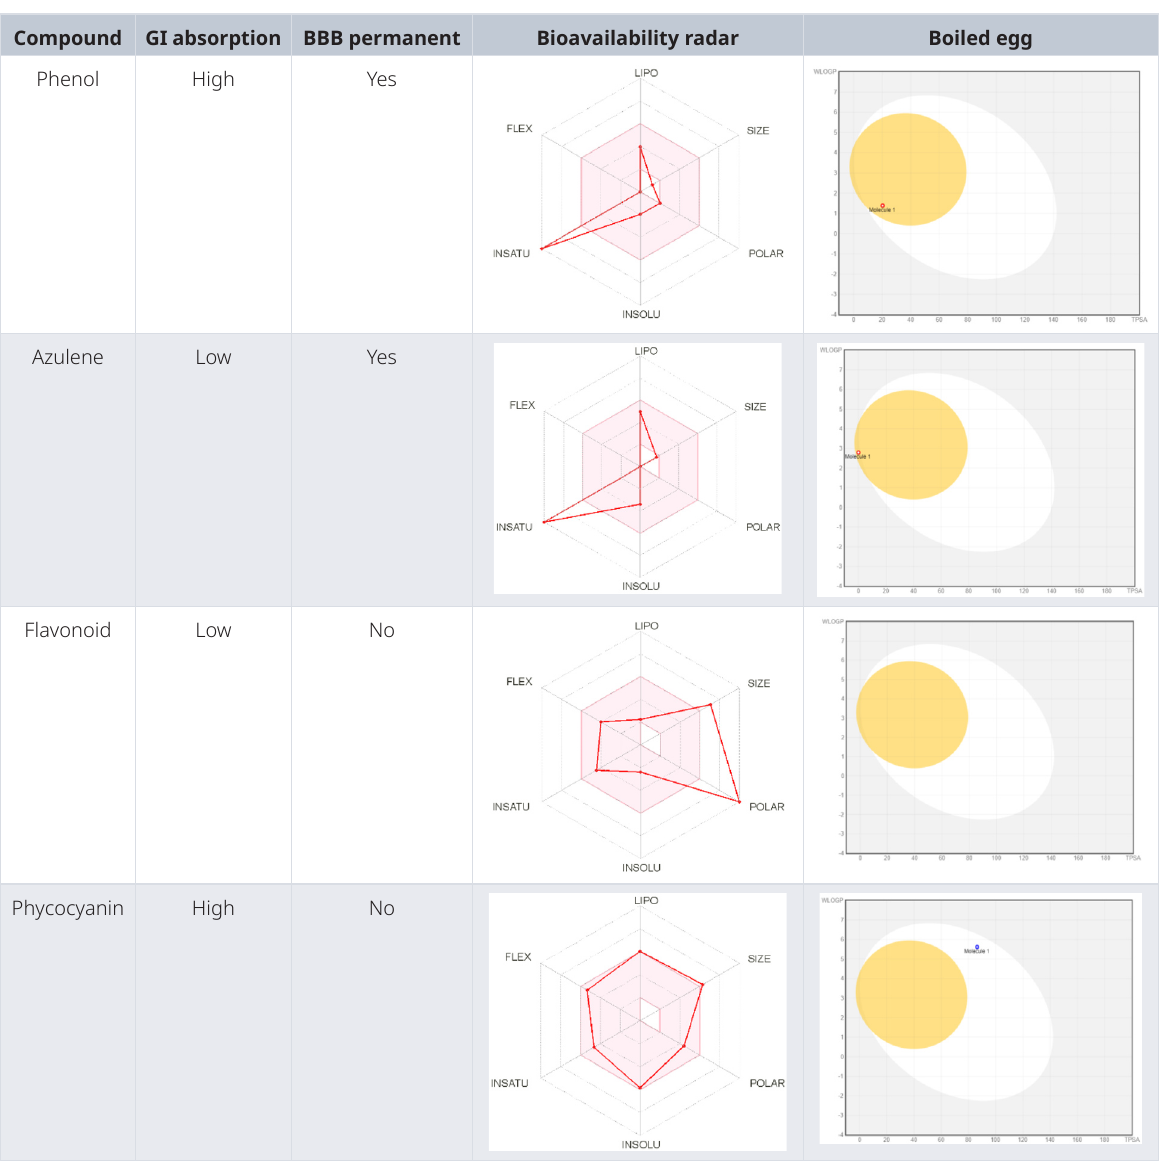
Table 1. Pharmacokinetics parameters of the analysis compound predicted by Swiss